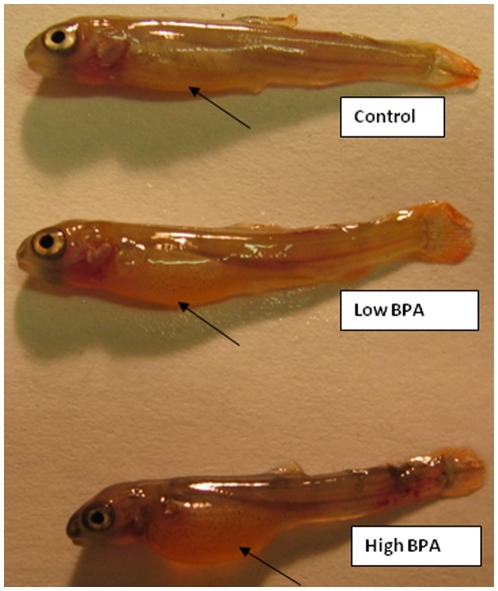
Impact of bisphenol A (BPA) on embryo development.Phenotypic changes post-hatch in trout embryos (65 dpf) treated with BPA. Rainbow trout oocytes were acutely exposed to either low (30 µg. ml−1) or high (100 µg.ml−1) BPA for 3 h, fertilized with untreated sperm, water hardened and maintained at 8.5°C. Image clearly shows morphological differences, including smaller size and the presence of yolk (arrow shown) in the BPA groups compared to the control.